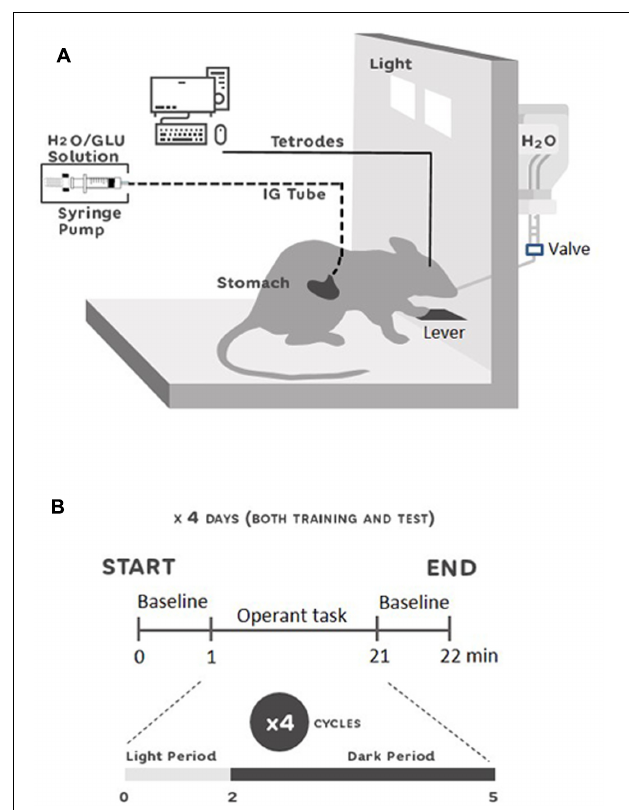
FIGURE 1 | Experimental setup (A) and single unit recording schedule (B) . (A) Skinner box used for the experiments equipped with a flat plastic floor, a stainless steel lever, a sipper spout protruding into the cage, and two halogen lights. IG-solutions were delivered through a gastric cannula using a syringe pump. Neural activity was recorded through a cable connected to the rat’s head. The rat could freely move in the chamber. (B) Recording schedule during the 4 days of training and test period. At 0 min the recordings were started with 1 min for baseline recording. Then, the protocol for the operant task in four cycles of 5 min started. At 21 min, the last baseline activity was recorded for 1 min. Each cycle was comprised of 2 min of light